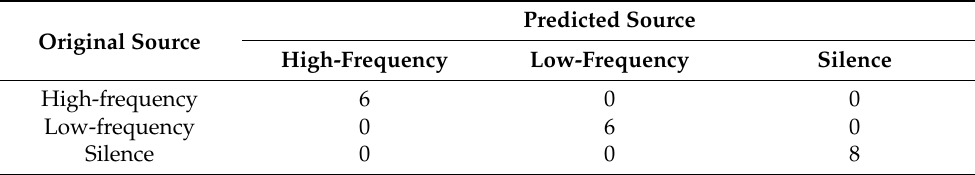
Table 1. Classification table obtained from leave-one-out cross-validation of 20 samples containing 24 aroma-associated volatile metabolites.